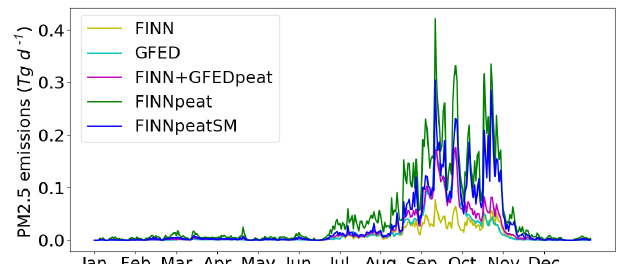
Figure 3. Total daily PM 2 . 5 emissions from fires during 2015. Total shown for the area in Fig. 1: 10 ◦ S–10 ◦ N, 95–120 ◦